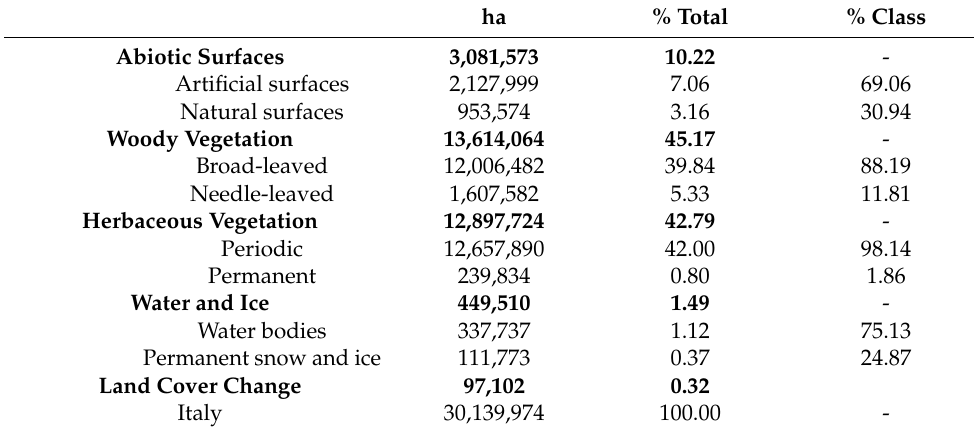
Table 8. Distribution of land cover classes for 2018 and land cover change for 2017–2018 on the Italian territory.